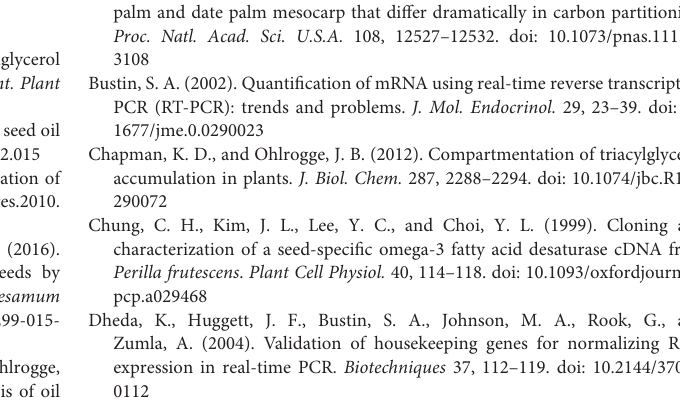
TABLE S3 | Gene-specific primer sequences for detection by qRT-PCR. TABLE S4 | Transcript levels of 10 genes in developing seeds of three tree peonies, relative to their S1 (A) and S1 of P. rockii (B) . Data with conditional formatting reveal the highest expression for each gene in red and lowest in